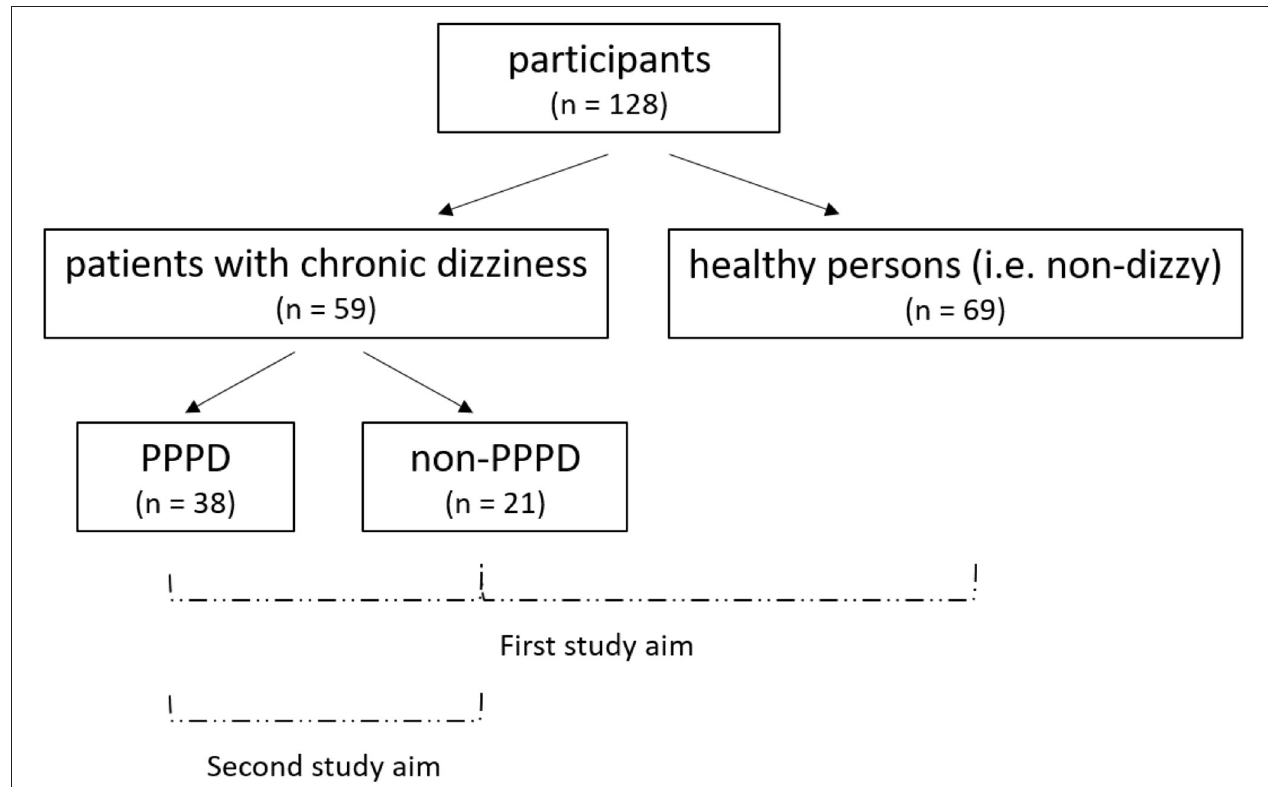
FIGURE 2 | Overview of the recruited samples and study aims a . First study aim: comparison of the clinical balance and visual dependence tests between PPPD patients, dizzy non-PPPD patients, and healthy persons. Second study aim: evaluation whether these clinical tests can help to identify PPPD in patients with chronic dizziness. a PPPD, persistent postural-perceptual